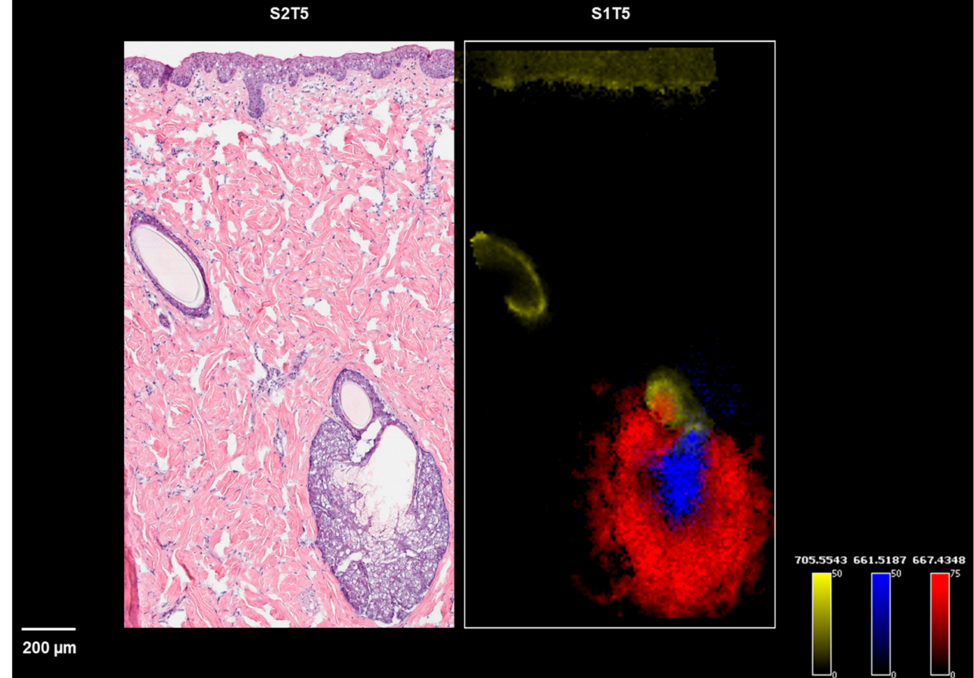
Figure 4. Ion images of m / z 667.4348 (a peripheral zone marker), m / z 661.5187 (a central zone marker), and m / z 705.5543 (a hair follicle and epidermis marker) on sections of S1T5, along with the H&E staining of S2T5.